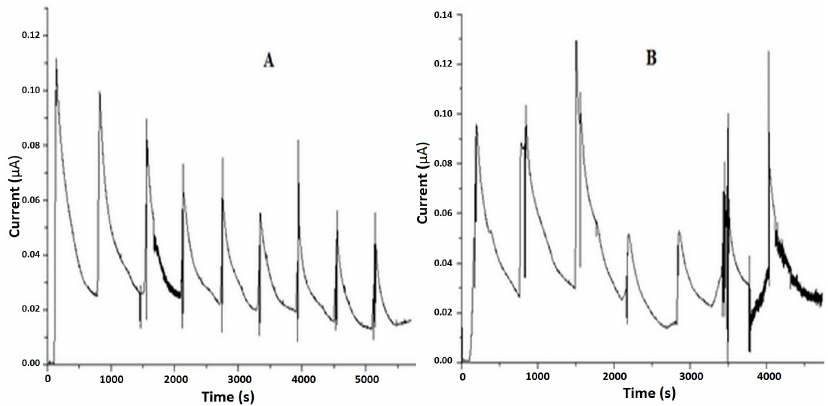
Figure 5. Qualitative cronoamperogram of NO release from Ru ‐ NO complex in HEPES buffer (pH 7.4) laser irradiated at ( A ) 355 nm (laser power 10 mW) and ( B ) 532 nm (laser power 30 mW).